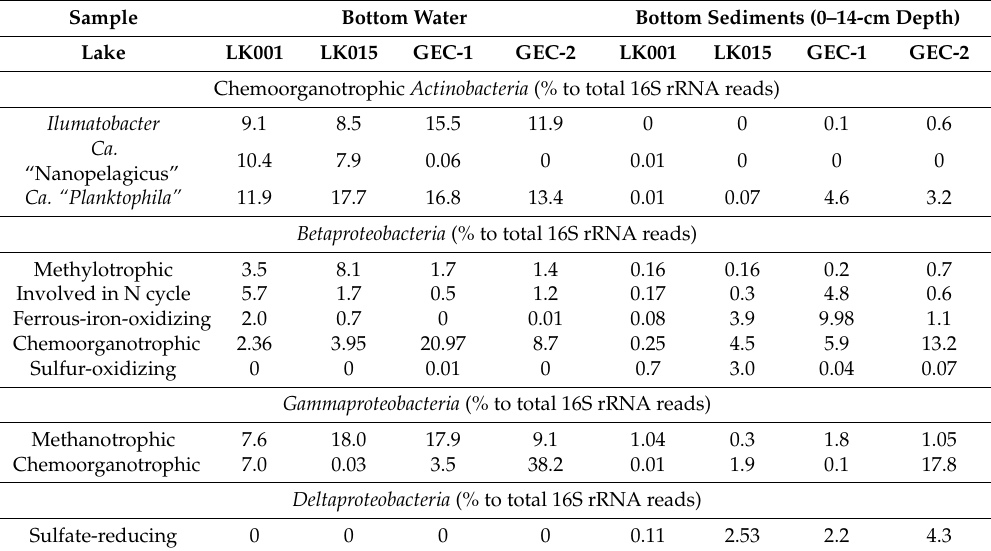
Table 4. The physiological affiliation of major bacterial phyla detected in Yamal